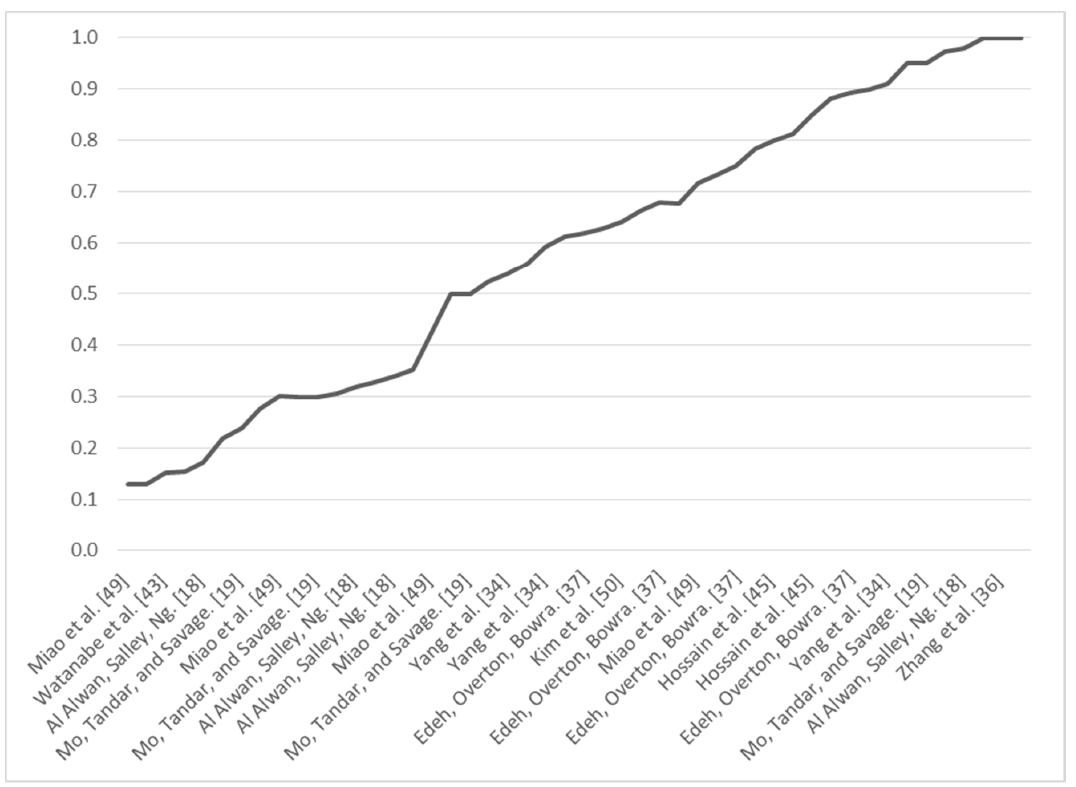
Figure 9. Conversion of fatty acids in hydrothermal experiments.